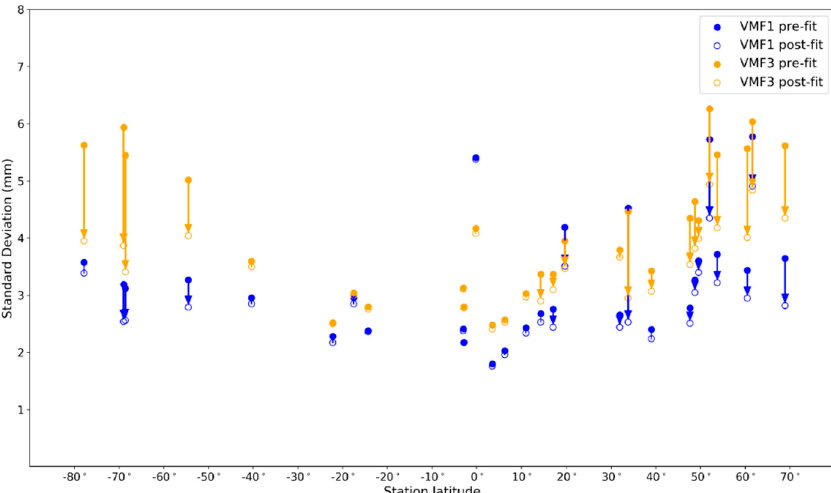
Figure 11. Standard deviations of biases for VMF1 and VMF3 SHD estimates with respect to radiosonde + ISA76 SHD estimates by ray-tracing for a 5 ◦ elevation angle, for the 28 stations of this study, over a 3-year period (1 January 2016 to 31 December 2018). The pre-fit and the post-fit are the standard deviations for the biases series before and after a yearly sine function